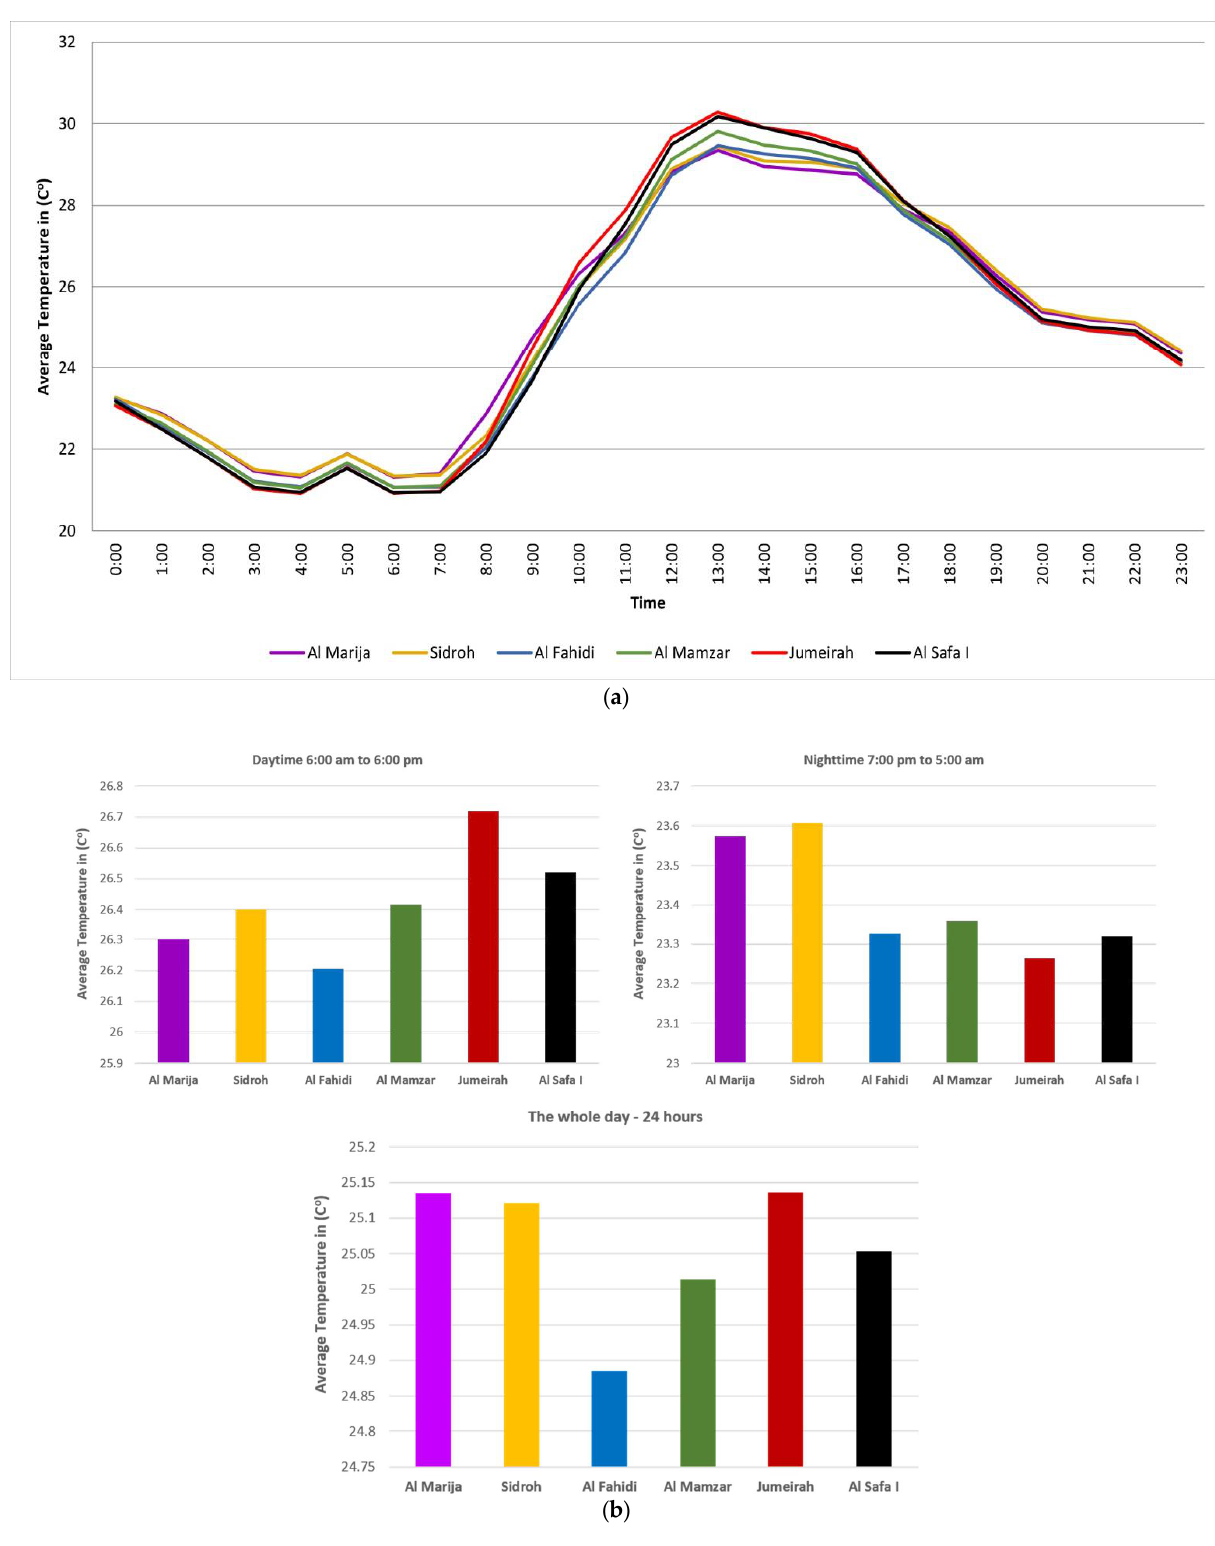
Figure 14. ( a ) Hourly variations of air temperature (˚C) for Al Marija, Sidroh, Al Fahidi, Al Mamzar, Jumeirah, and Al Safa I in April. ( b ) Average air temperature (˚C) for daytime, nighttime, and the whole 24 h in April.